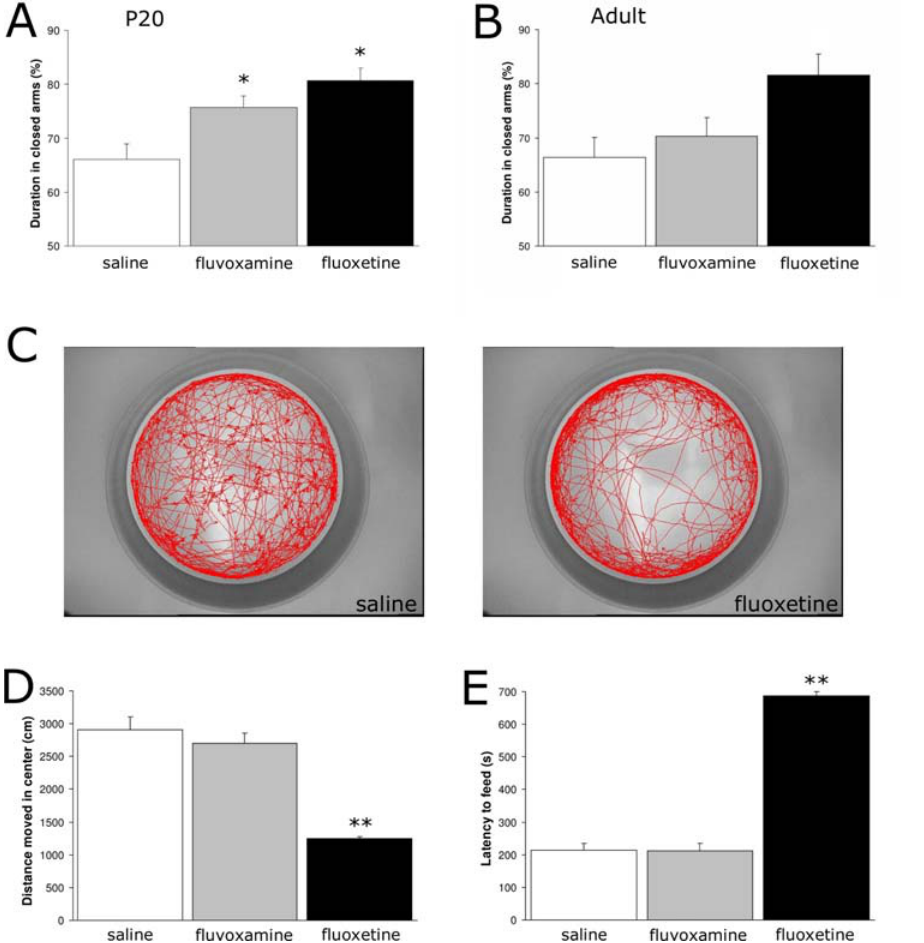
Figure 4. Behavioral data of the elevated plus maze (A, B), open field (C, D) and the novelty suppressed feeding test (E) presented as mean 6 S.E.M. All behavioral test were performed with 3 groups: saline (white bars), fluvoxamine (gray bars) and fluoxetine (black bars). Panel C shows a typical example of a walking pattern in the open field (30 min) of a saline- and a fluoxetine-treated mouse. * p , 0.05; ** p , 0.01.